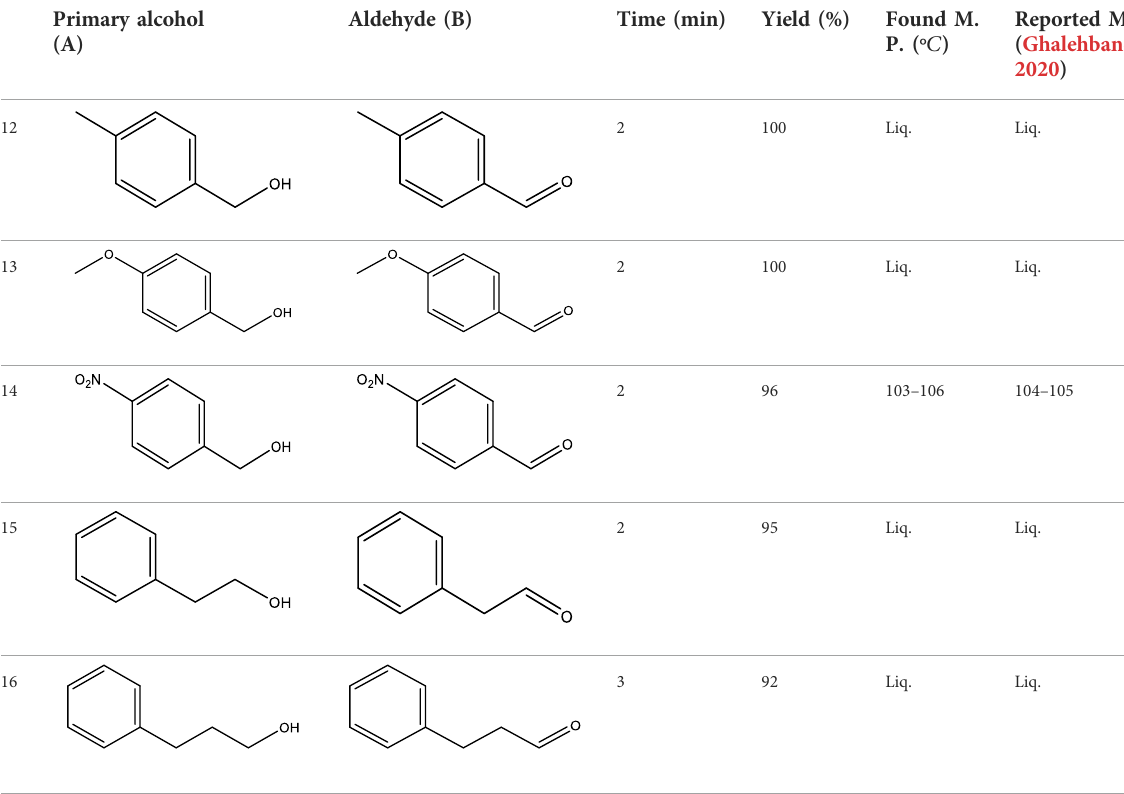
TABLE 2 ( Continued ) Green oxidation of primary alcohol derivatives to aldehyde derivatives using CCPSF NPs under MW irradiation.